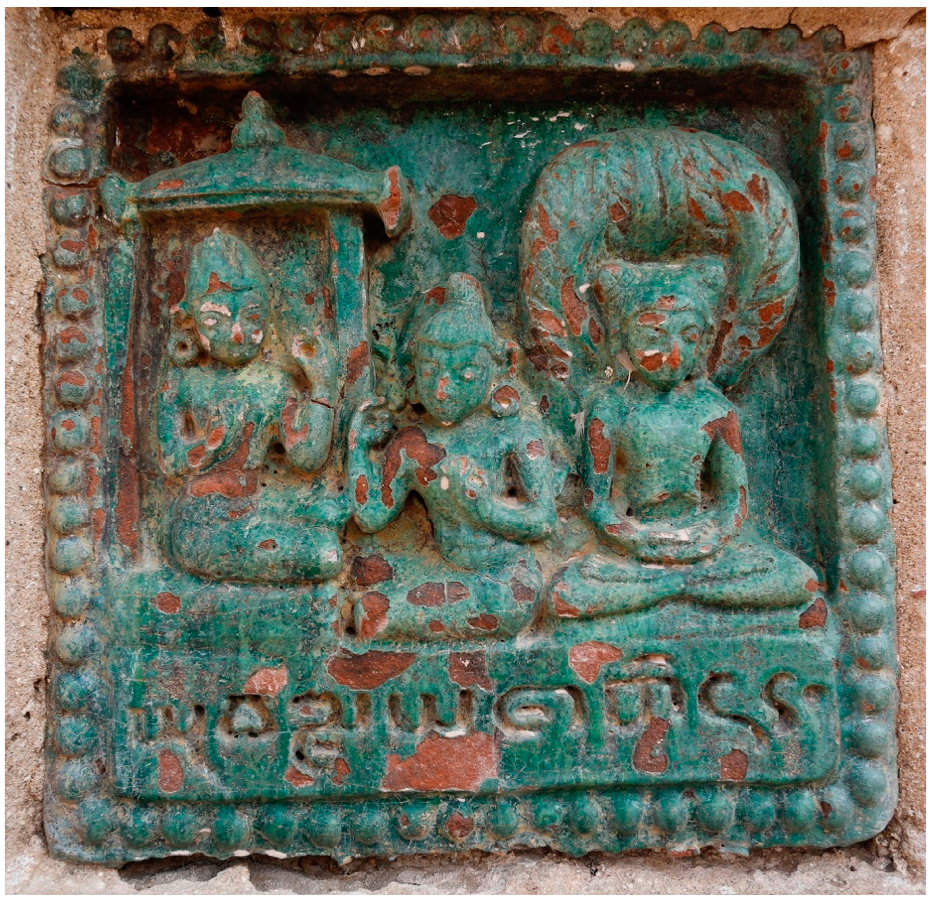
Figure 16. Pagan, Ananda, 11th century. Yuvanjaya, Jataka 460. A monoscenic interpretation, on a glazed plaque, encapsulating a story linking sighting a natural phenomenon—the sun burning away the dew—and grasping thereby life’s meaning.